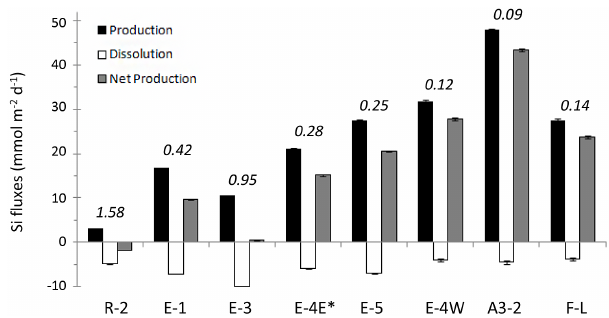
Figure 5. Si uptake (black), biogenic silica dissolution (white) and net silica production (grey) integrated over the euphotic layer (1% of photosynthetically active radiation). Italic values correspond to the integrated dissolution-to-production ratio ( ∫ D : ∫ P ) ∗ Since no dissolution rates were measured at E-4E, dissolution and net pro- duction do not correspond to calculations from direct measurements but only to estimations. Dissolution was calculated as the average of all KEOPS-2 integrated dissolution